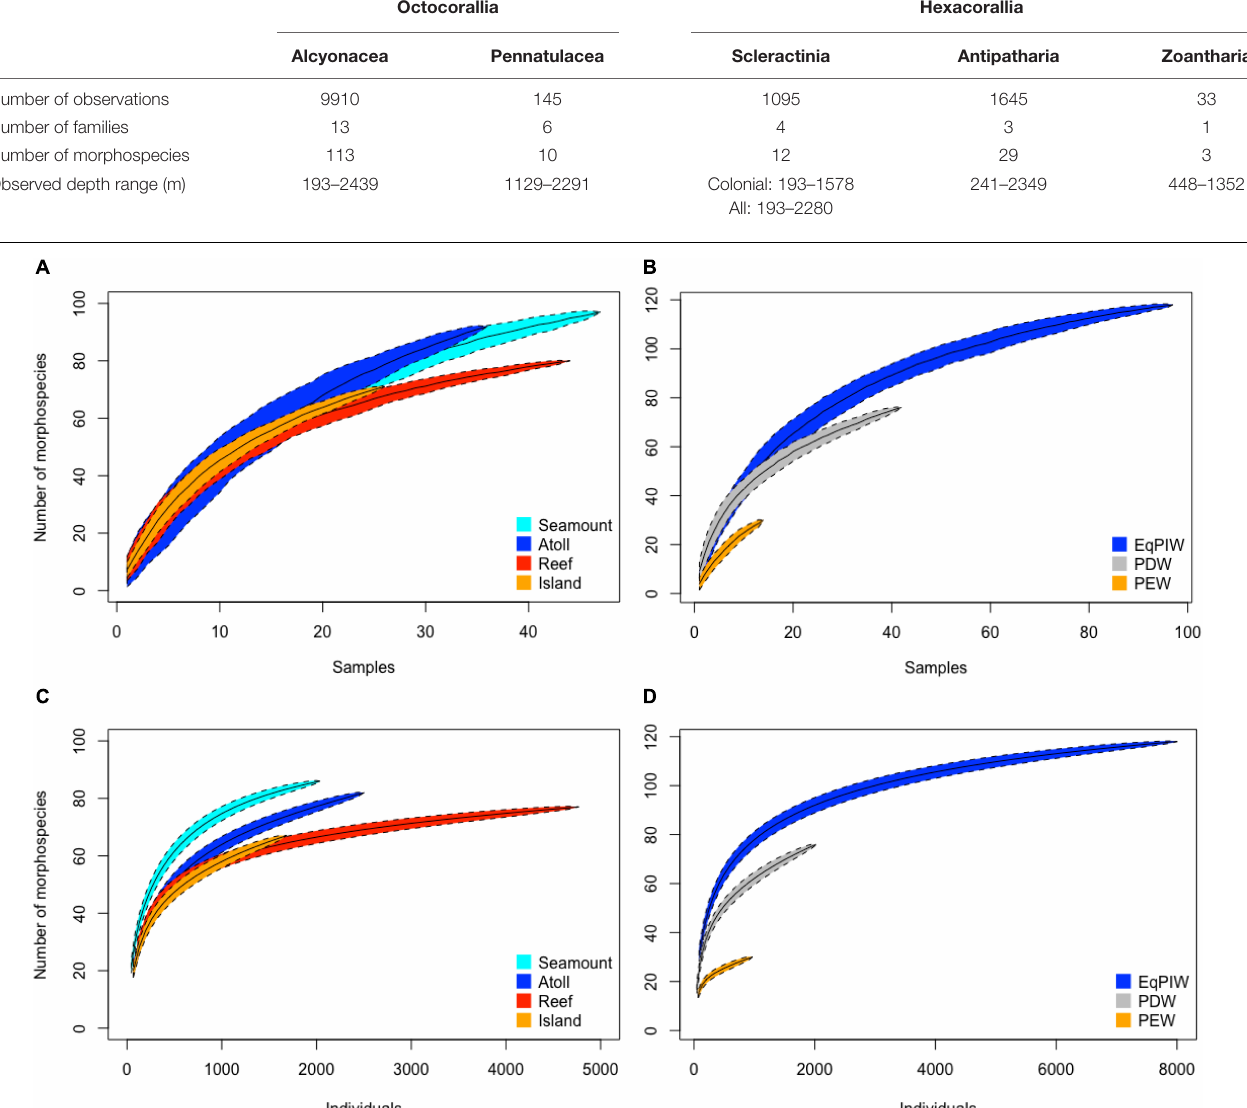
TABLE 3 | Summary of deep-water coral observations from ROV video by taxonomic groupings.